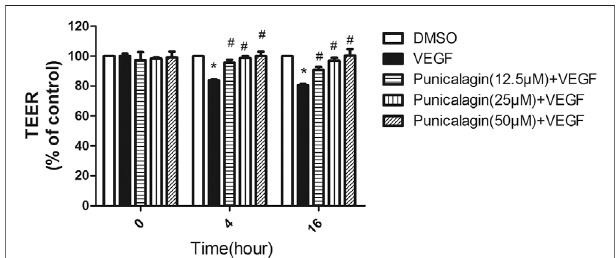
FIGURE 5 | Effect of punicalagin on vascular hyperpermeability in vitro . Electrical resistance of a monolayer of HUVECs was measured by transendothelial electrical resistance (TEER). The experiments were performedintriplicate.Dataarerepresentedadmean ± SD.* p < 0.05vs. DMSO groups, # p < 0.05 vs. treatment with VEGF